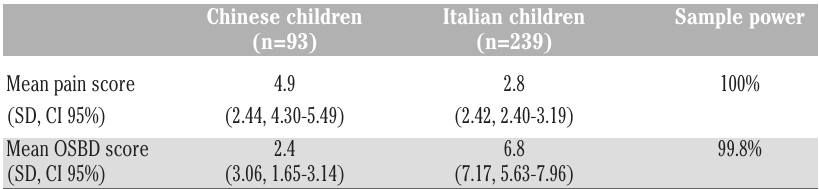
Table 4. Differences in the mean pain and Observational Scale of Behavioral Distress (OSBD) scores of primary school Chinese and Italian children.